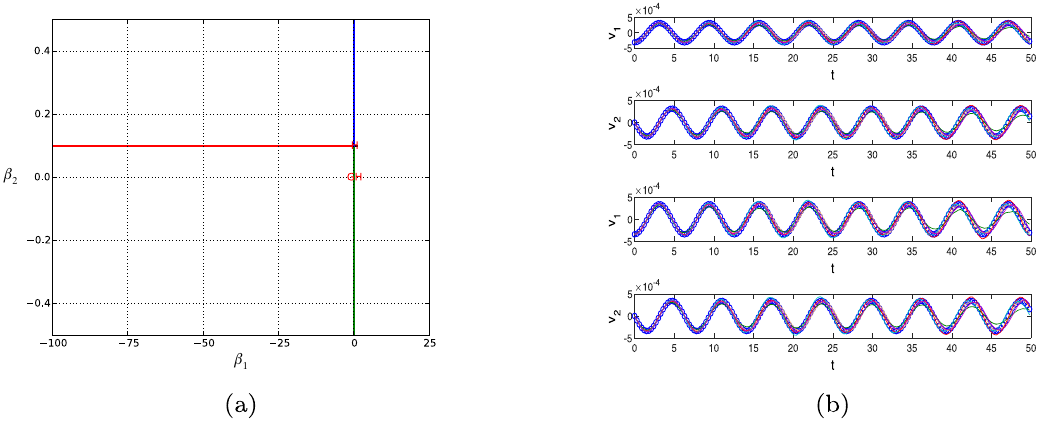
Figure 2: ( a ) The bifurcation diagram of equation ( 1 ) and ( b ) the time series for double limit cycles.